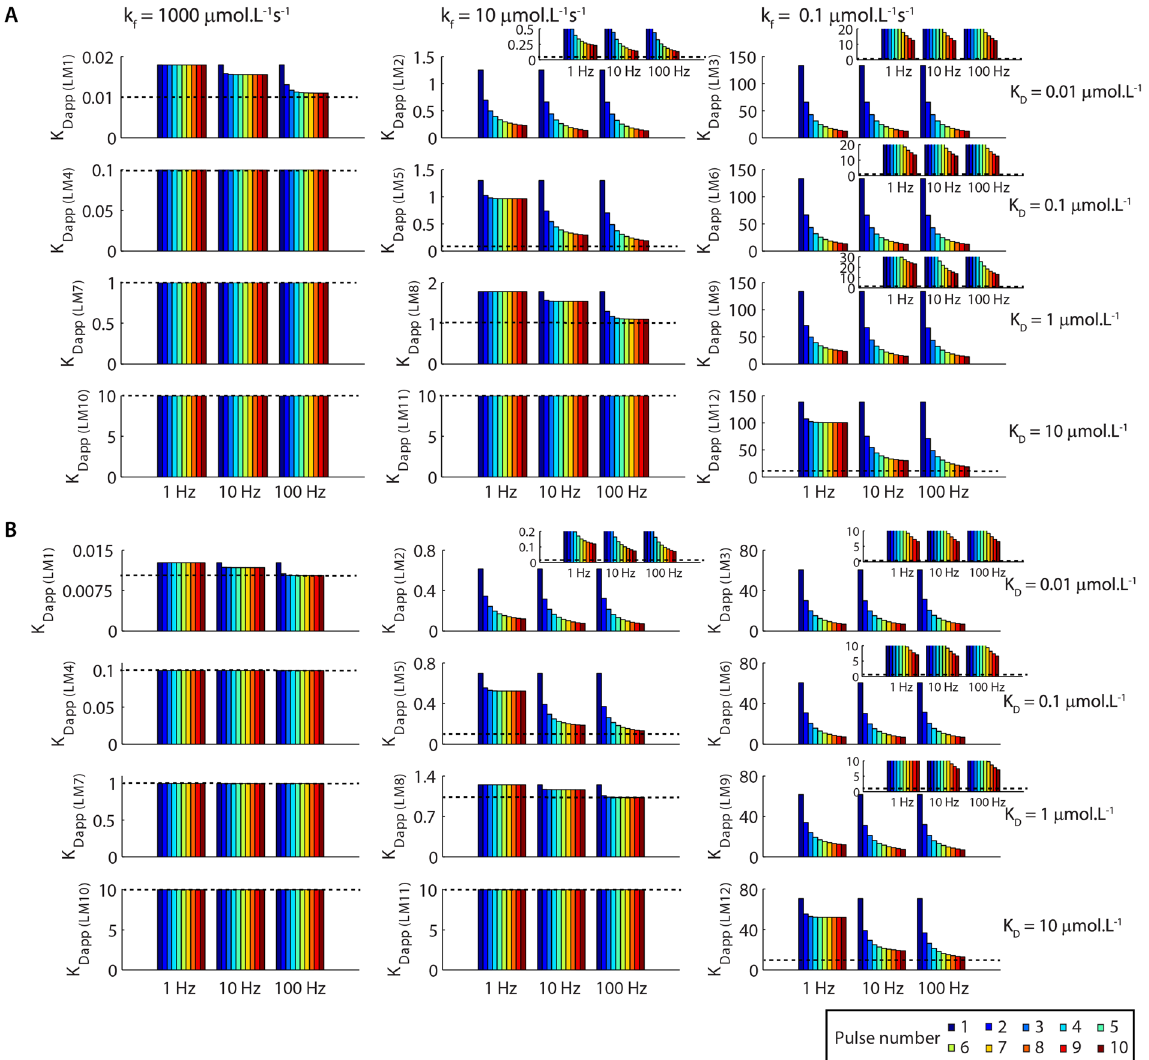
Figure 6. Variations of the K Dapp s observed for the stimulations of the model with trains of pulses of [L] free . We estimated the K Dapp s (in µ mol.L − 1 ) from dose-responses curves showed in Suppl. Figs S4 and S5. The results showed in ( A) and ( B) were obtained for pulses of 50 ms and 100 ms, respectively. The dashed lines correspond to the control K D s, also indicated on the right of the panels, the k f s for the association reactions are indicated in A . The insets show the same results in different scales for better visualization. The legend shows the colour code used to represent the pulse number of [L] free